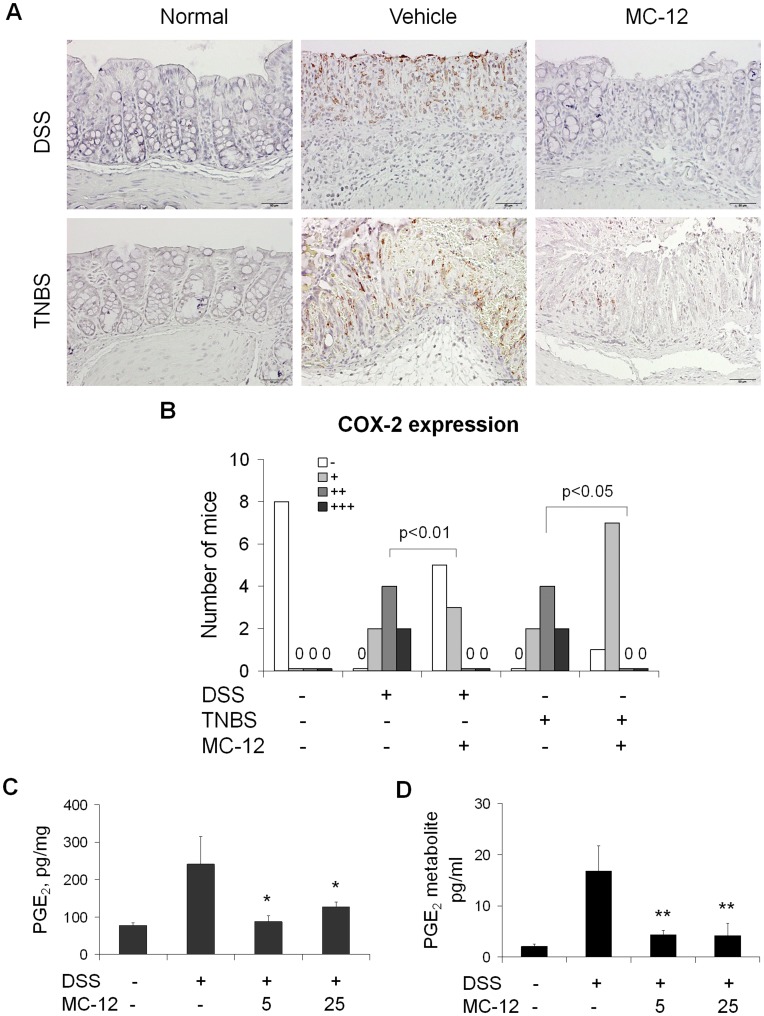
MC-12 inhibits COX-2 induction and decreases PGE2 levels in DSS- and TNBS-induced colitis. A:
Representative photomicrographs of tissue sections with COX-2 immunohistochemical staining on colon tissue from normal (no treatment), vehicle- or MC-12-treated mice from the DSS (upper panels) or TNBS (lower panel) groups. MC-12 treatment: 25 mg/kg ip. B: The COX-2 expression scores in the various groups of animals (n = 8/group). Differences were evaluated by Pearson’s χ2 method. C, D: MC-12 decreased the levels of PGE2 in colonic mucosa and of PGE2 metabolite in serum. Values are mean ± SEM. **p<0.01 compared to vehicle-treated group, *p<0.05 compared to vehicle-treated group.